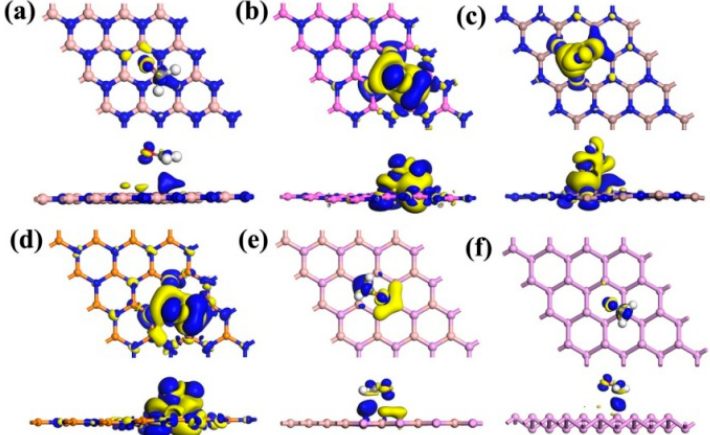
Figure 3. Charge density differences for the CH 2 O adsorbed on the surface of the ( a ) BN, ( b ) AlN, ( c ) GaN, ( d ) InN, ( e ) BP, and ( f ) P monolayers with an isosurface value of 0.003 e/Å 3 . The blue and yellow contours denote the increase and decrease of electrons, respectively.